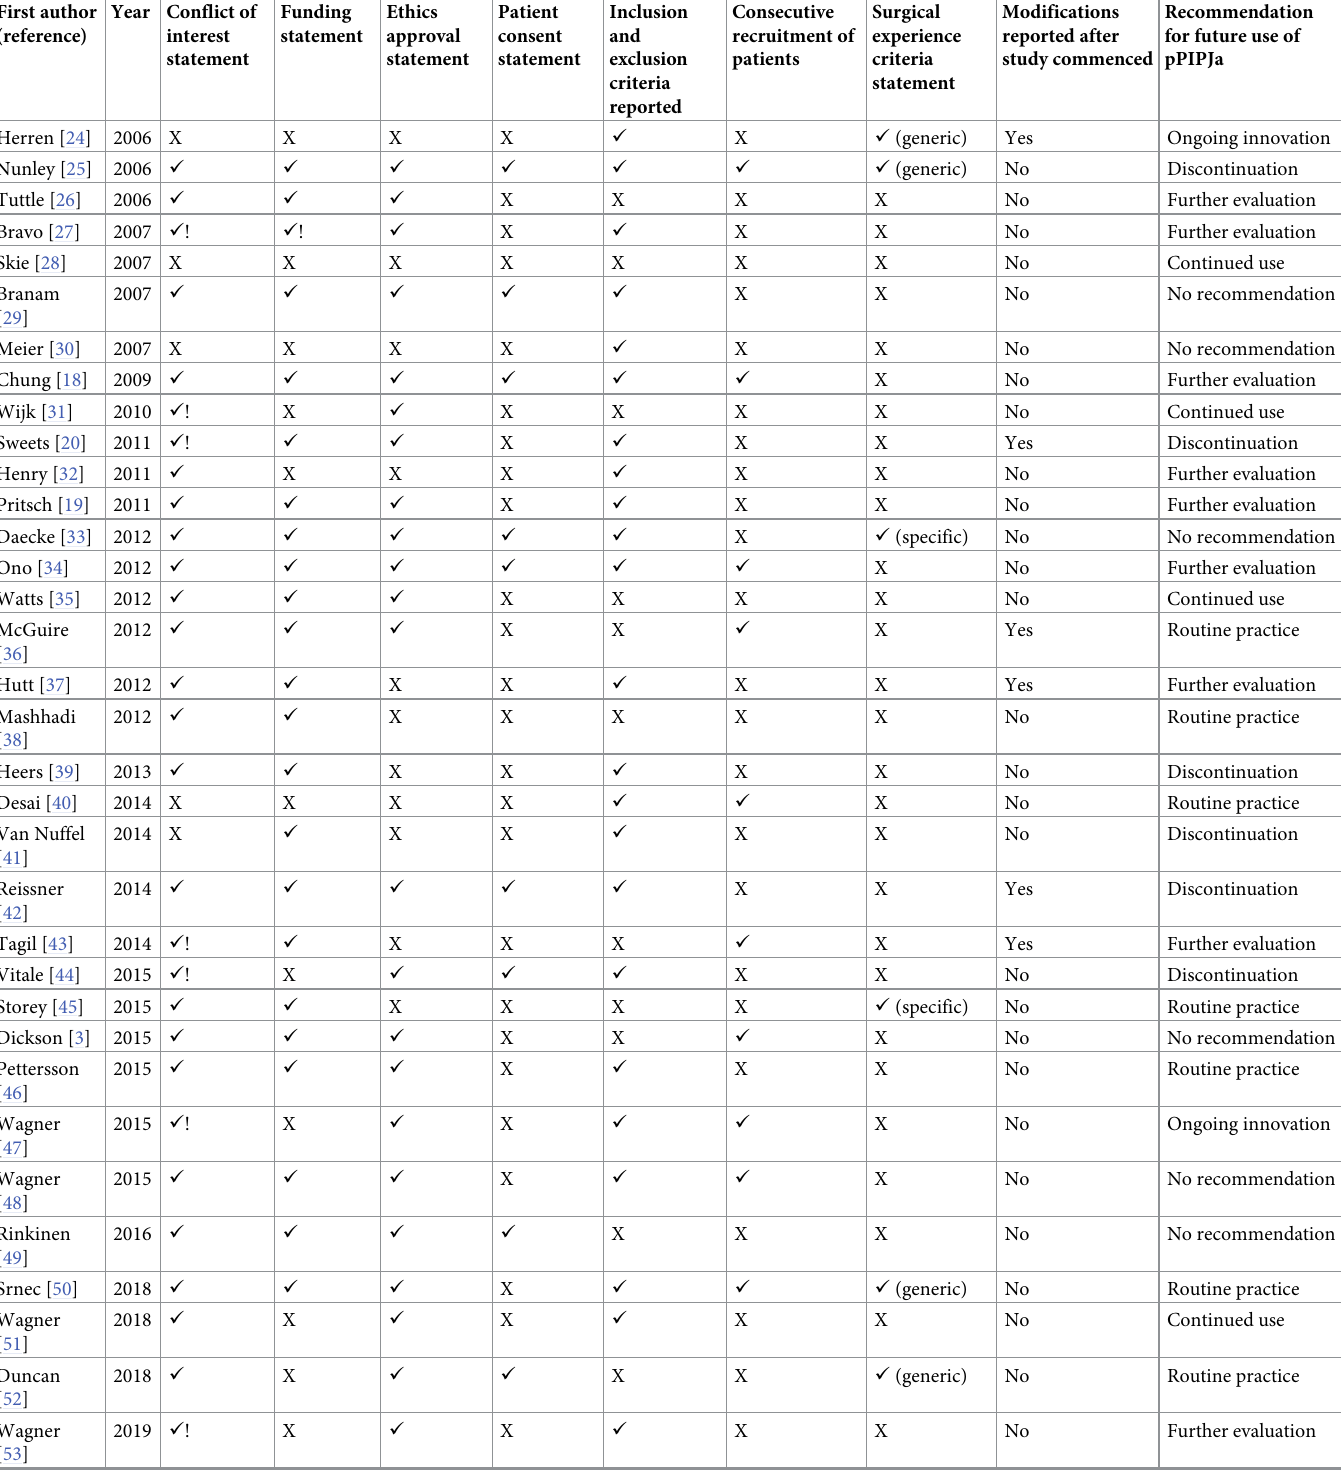
Table 2. Overview: Patient selection, regulatory and governance arrangements, operator expertise and